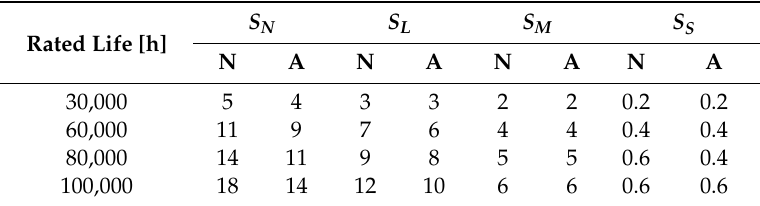
Table 5. Remaining lives of bearings in different states [year].